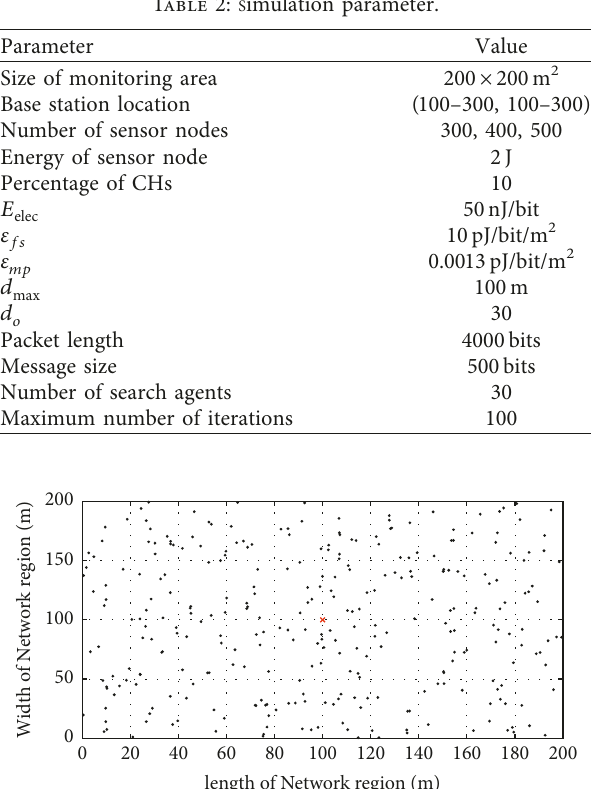
Figure 3: Random deployment of a wireless sensor network with 300 nodes.